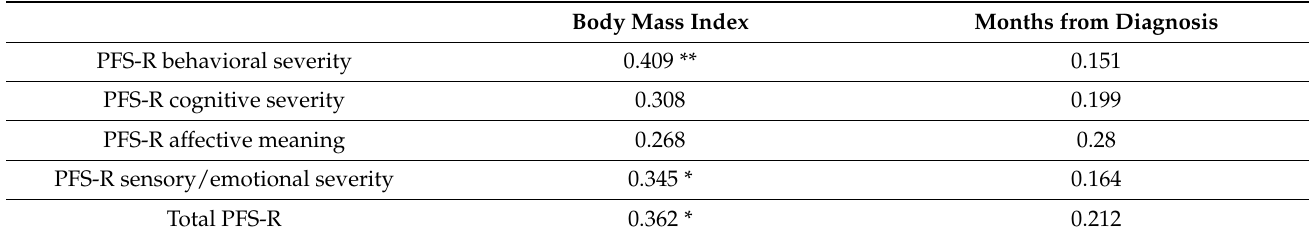
Table 4. Cross-cultural validity: Pearson correlation coefficient between the Revised Piper Fatigue Scale (PFS-R) and patient demographic